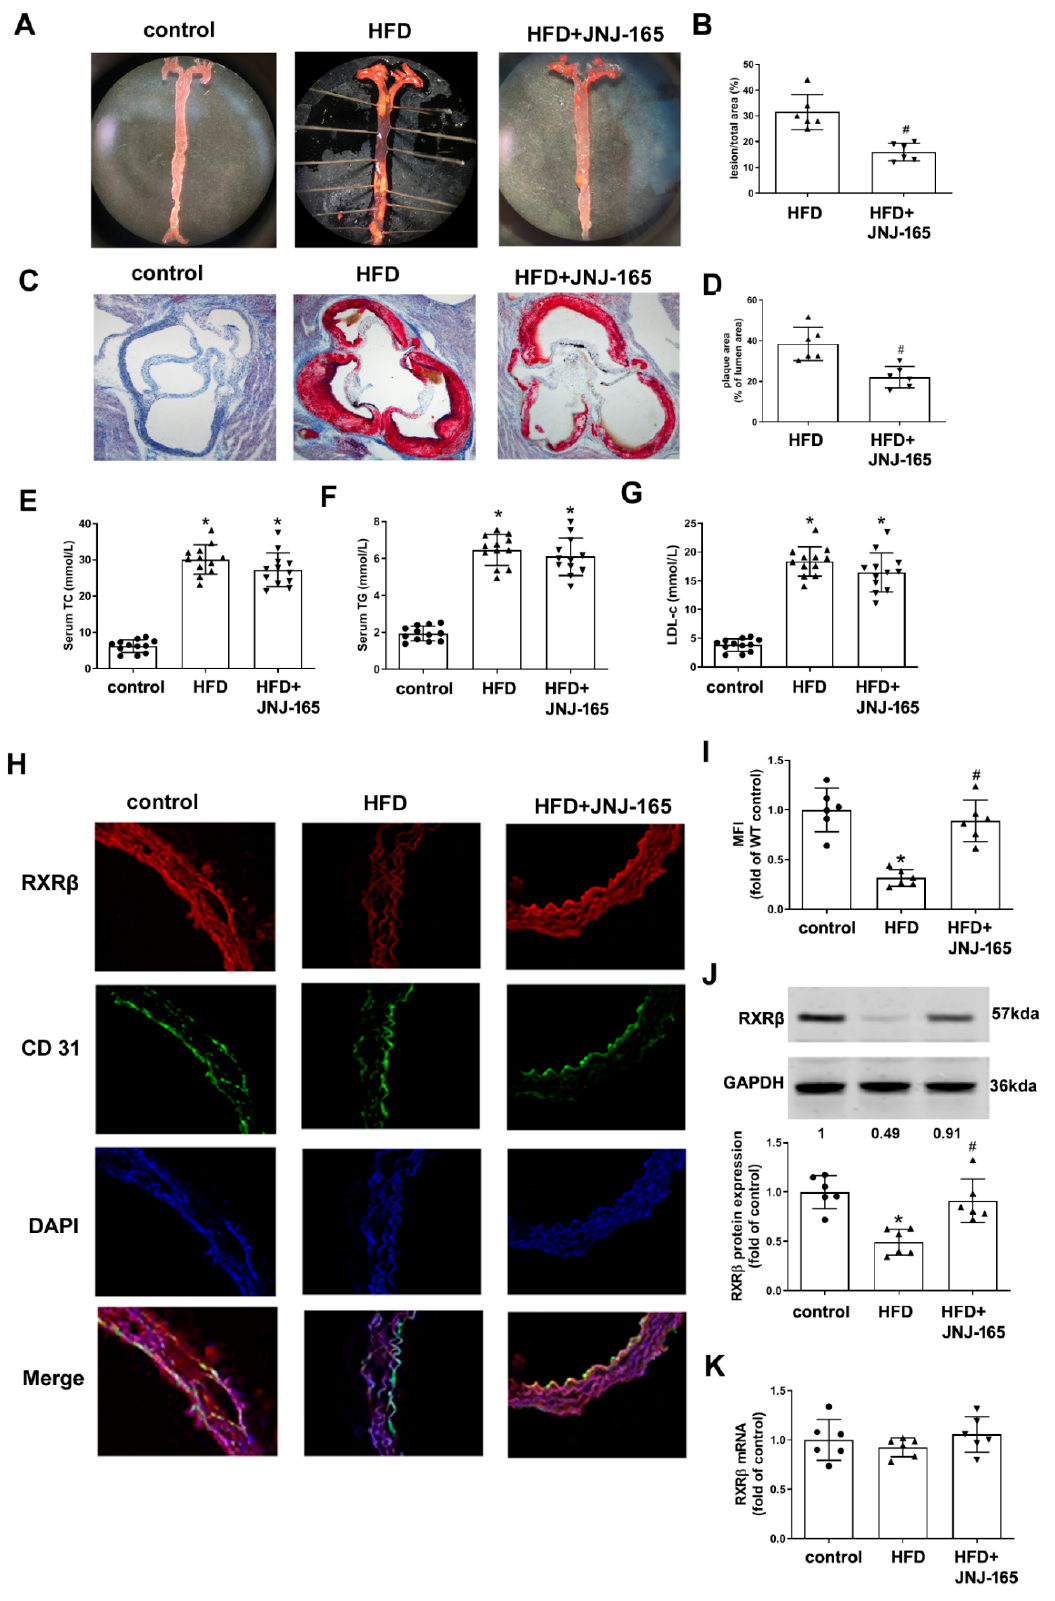
Figure 8. MDM2 inhibition alleviates atherosclerotic lesion formation and RXR β protein expression in HFD-fed LDLr -/- mice. ( A , B ) Representative images and quantification of Oil Red O staining of en face preparations of aortas. n = 6. ( C , D ) Representative images and quantification of aortic